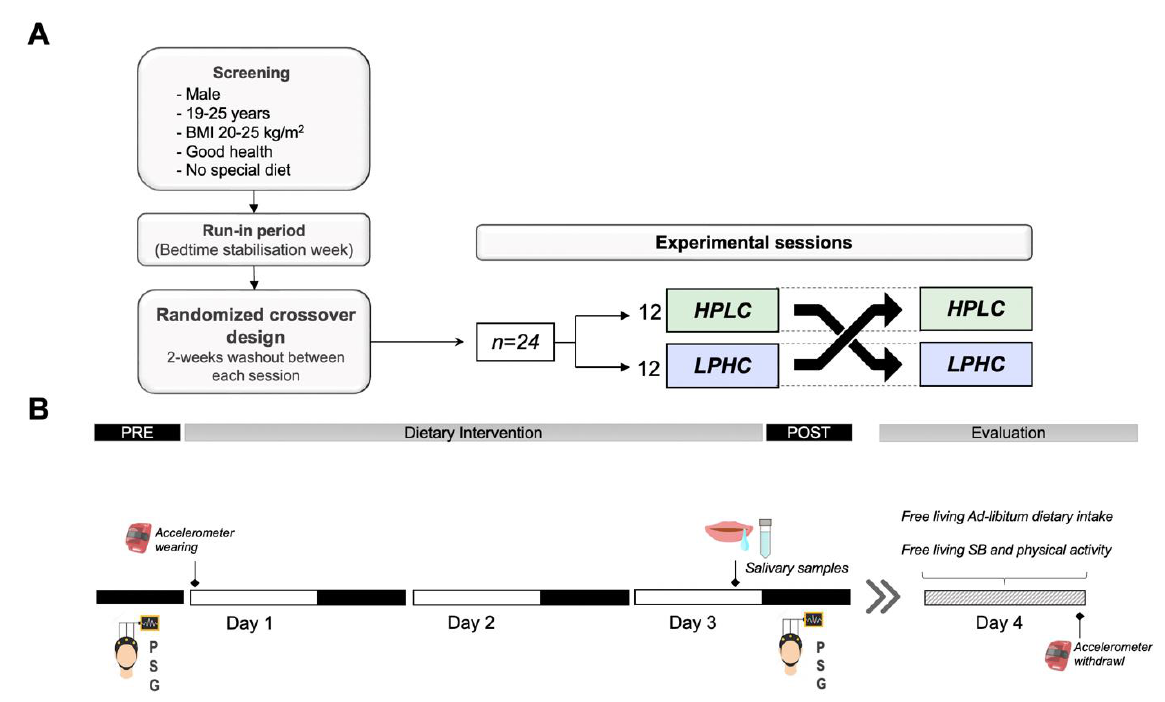
Figure 1. Study overview. ( A ) A randomized, crossover study design including two sessions on isocaloric diets whether HPLC or LPHC. ( B ) Each session comprised three days of intervention during which sleep was measured by polysomnography. Salivary samples were collected on the third day of each session from melatonin assessment. The intervention was followed by 24-h free living evaluation of physical activity, and ad-libitum dietary intake; SB: sedentary behavior.